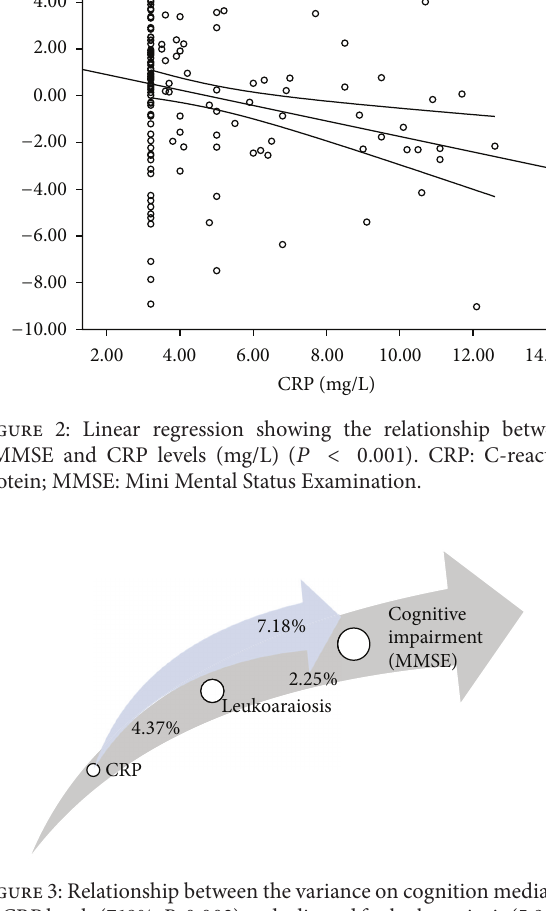
Figure 3: Relationship between the variance on cognition mediated byCRPlevels(7.18%; 𝑃 :0.002)andadjustedforleukoaraiosis(5.98%; 𝑃 : 0.005). CRP: C-reactive protein; MMSE: Mini Mental Status